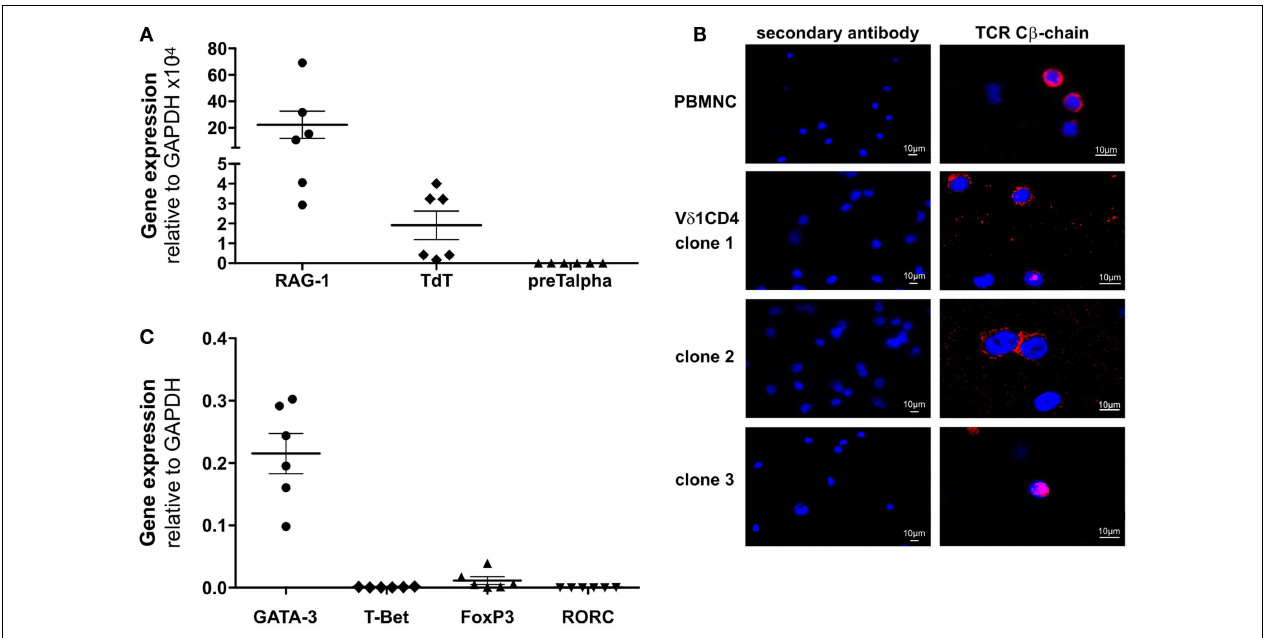
standard culture conditions, which mimic mild inflammation [blue: DAPI; Axiophot microscope (Zeiss)]. (C) Transcription factors expressed by CD4 + V δ 1 + T-cell clones, determined by real-time RT-PCR. GATA-3 (mean: 0.22 ± 0.03 SEM),T-bet (mean: 0.0009 ± 0.0002 SEM), Foxp3 (mean: 0.01 ± 0.006 SEM), and RORC (mean: 0.0001 ± 0.00008